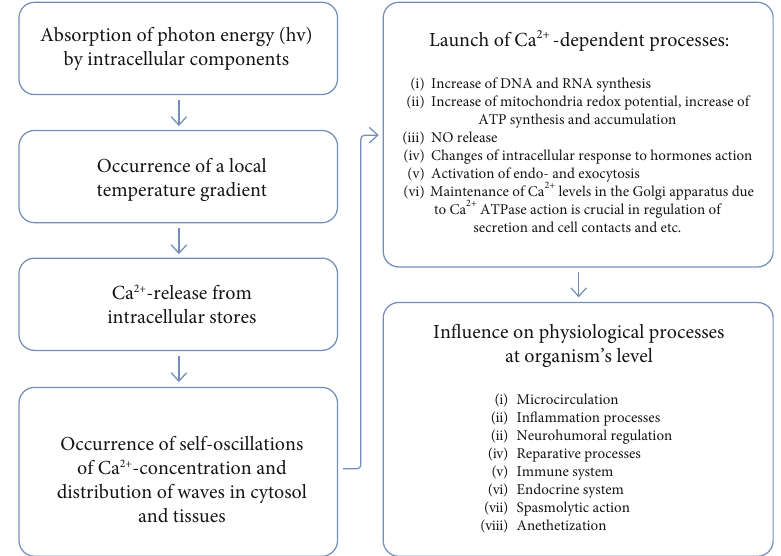
Figure 1: Biological e ff ects of